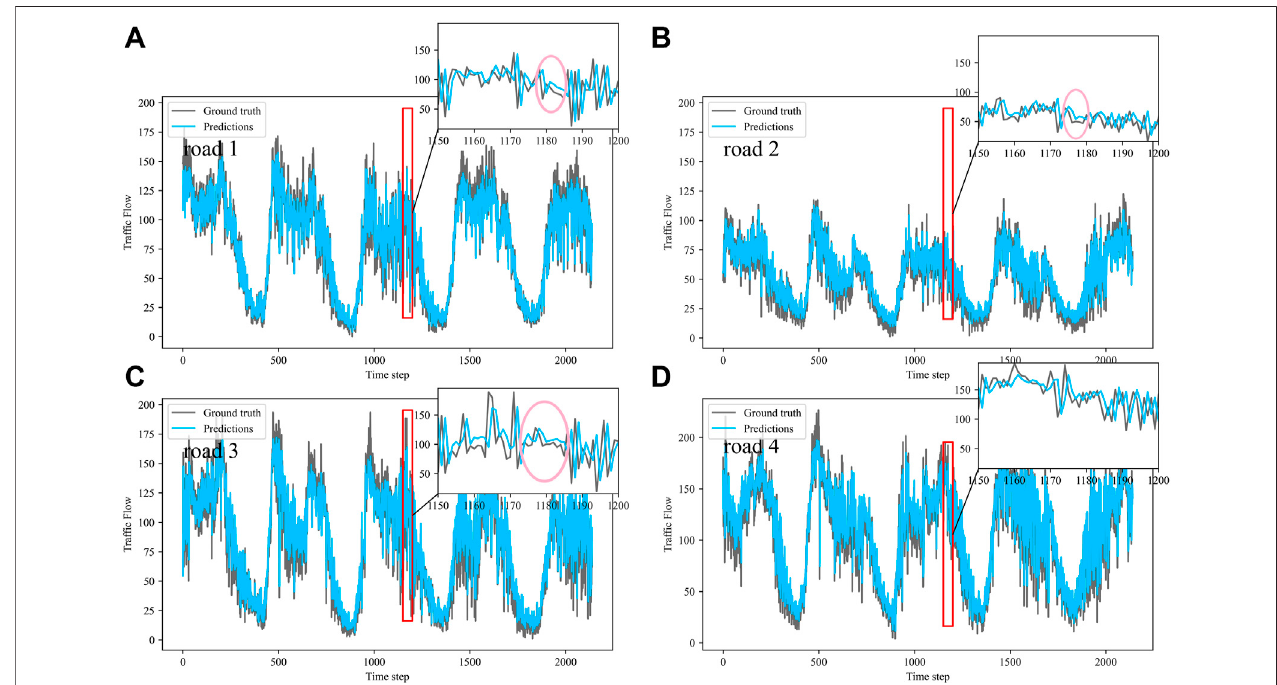
FIGURE 14 | Visualization of IMgru model prediction results on the complete dataset. (A) road 1 means Gudun Road. (B) road 2 means Fengtan Road. (C) road 3 means Yile Road. (D) road 4 means Jingzhou Road.